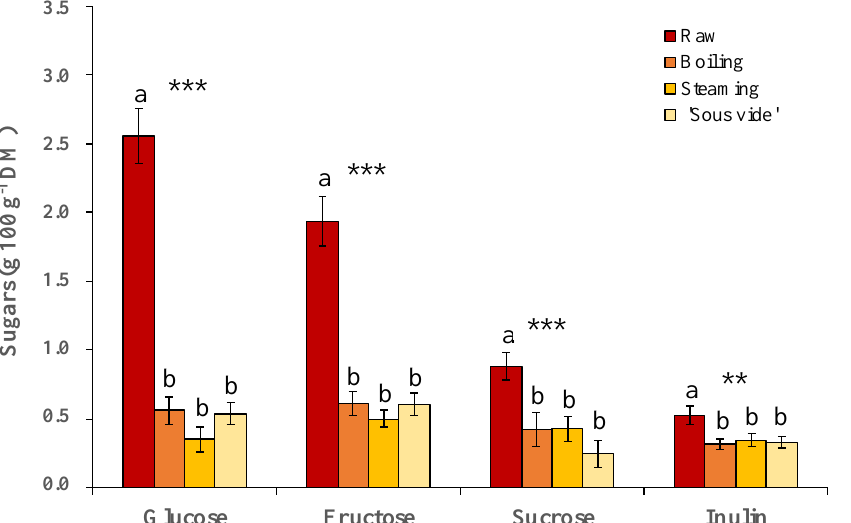
Figure 5. Content of glucose, fructose, sucrose, and inulin in golden thistle midribs raw and cooked by boiling, steaming, and ‘sous vide’. Vertical bars indicate the standard deviation. Different letters indicate statistically different mean values ( n = 3) at α = 0.05 between treatments. Significance: ** and ***, significant at p ≤ 0.01 and p ≤ 0.001, respectively.